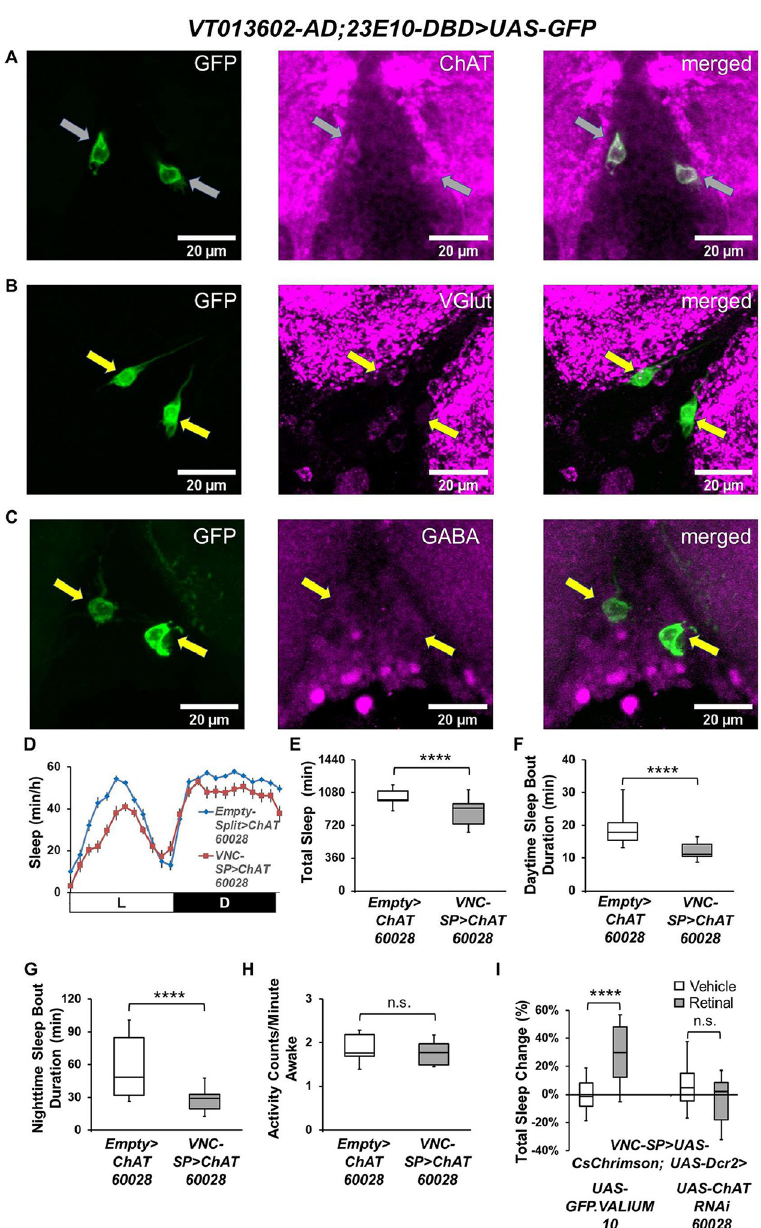
Fig 4. VNC-SP neurons are cholinergic. ( A–C ) Representative confocal stacks focusing on the metathoracic ganglion of the VNC of female VT013602-AD; 23E10-DBD > UAS-GFP flies stained with antibodies to ChAT (A), VGlut (B), and GABA (C). Gray arrows in (A) indicate colocalization of GFP and ChAT staining in VNC-SP neurons. Yellow arrows in (B) and (C) indicate the localization of VNC-SP neurons. Green, anti-GFP; magenta, anti-ChAT (A), anti- VGlut (B), anti-GABA (C). ( D ) Sleep profile in minutes of sleep per hour for control ( Empty-AD; 23E10-DBD > UAS-ChAT RNAi 60028 , blue line) and VNC-SP > ChAT RNAi 60028 ( VT013602-AD; 23E10-DBD > UAS-ChAT RNAi 60028 , red line) female flies. ( E ) Box plots of total sleep time (in minutes) for flies presented in (D). A two-tailed unpaired t test revealed that VNC-SP > ChAT RNAi 60028 flies sleep significantly less than controls. ���� P < 0.0001, n = 22–30 flies per genotype. ( F ) Box plots of daytime sleep bout duration (in minutes) for flies presented in (D). A two-tailed Mann–Whitney U test revealed that VNC-SP > ChAT RNAi flies daytime sleep bout duration is significantly reduced compared with controls. ���� P < 0.0001, n = 22–30 flies per genotype. ( G ) Box plots of nighttime sleep bout duration (in minutes) for flies presented in (D). A two-tailed Mann–Whitney U test revealed that VNC-SP > ChAT RNAi flies nighttime sleep bout duration is significantly reduced compared with controls. ���� P < 0.0001, n = 22–30 flies per genotype. ( H ) Box plots of locomotor activity counts per minute awake for flies presented in (D). A two-tailed Mann–Whitney U test revealed that there is no difference in waking activity between